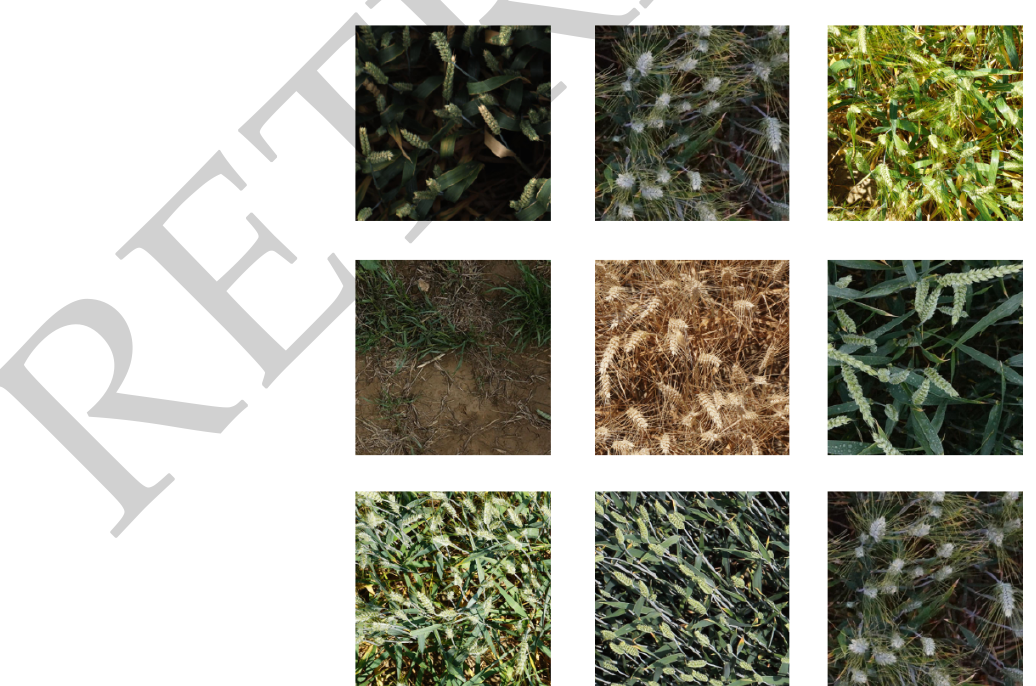
Figure 1. Samples of the